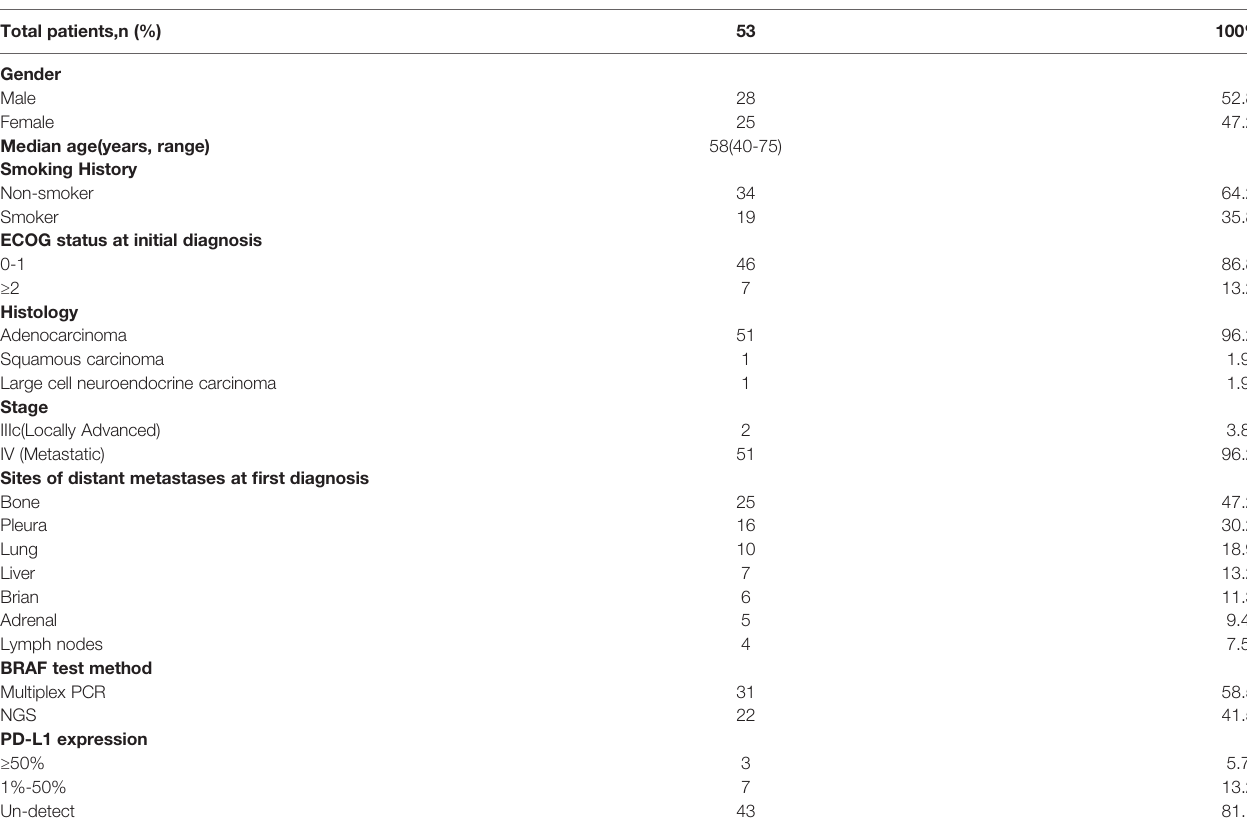
TABLE 1 | Baseline